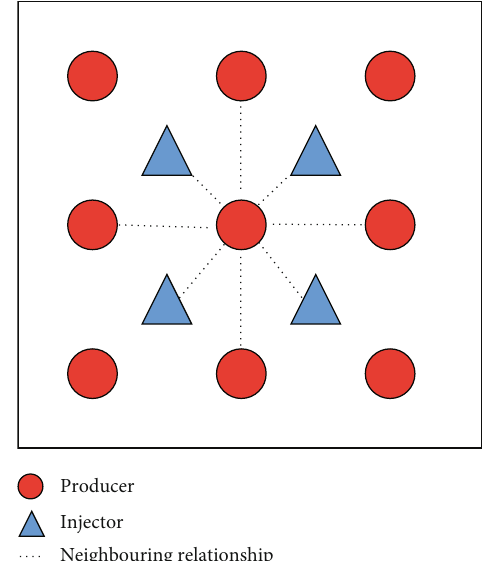
Figure 3: Variables screened for model